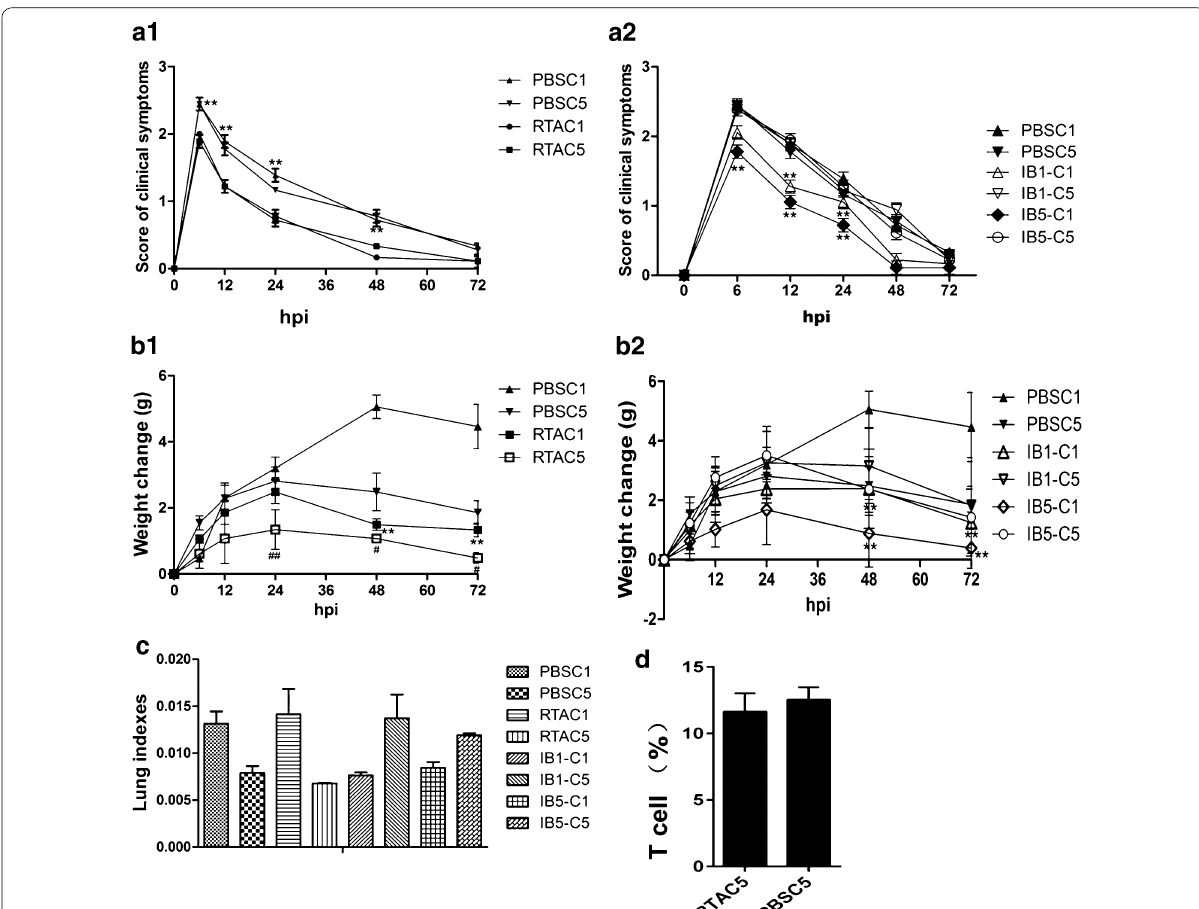
Fig. 4 Detection of the clinical symptoms, weight changes, lung indexes, and number of T cells in the lungs of the mice from different groups. Each group had 6 mice. a1 , a2 The clinical symptoms of each mouse were observed and scored at 0, 6, 12, 24, 48 and 72 h after challenge. b1 , b2 The weight of each mouse was recorded at 0, 6, 12, 24, 48, and 72 h after challenge, and the weight changes of the mice were calculated (weight changes the initial weight- the real-time weight); * represents the RTAC1 group or the IB5-C1 group or the IB1-C1 group compared with the = PBSC1 group and was statistically significant; # represents the RTAC5 group or the IB1- C5 group or the IB5-C5 group compared with the PBSC5 group and was statistically significant. c The body weight and the lung weight of the mice were recorded at 72 h after challenge, and the lung indexes of the mice were calculated. d The mice in the RTAC5 and PBSC5 groups were challenged with APP5b . The number of T cells in the lungs was detected by flow cytometry at 72 h after challenge. * or #, P < 0.05; ** or ##, P <